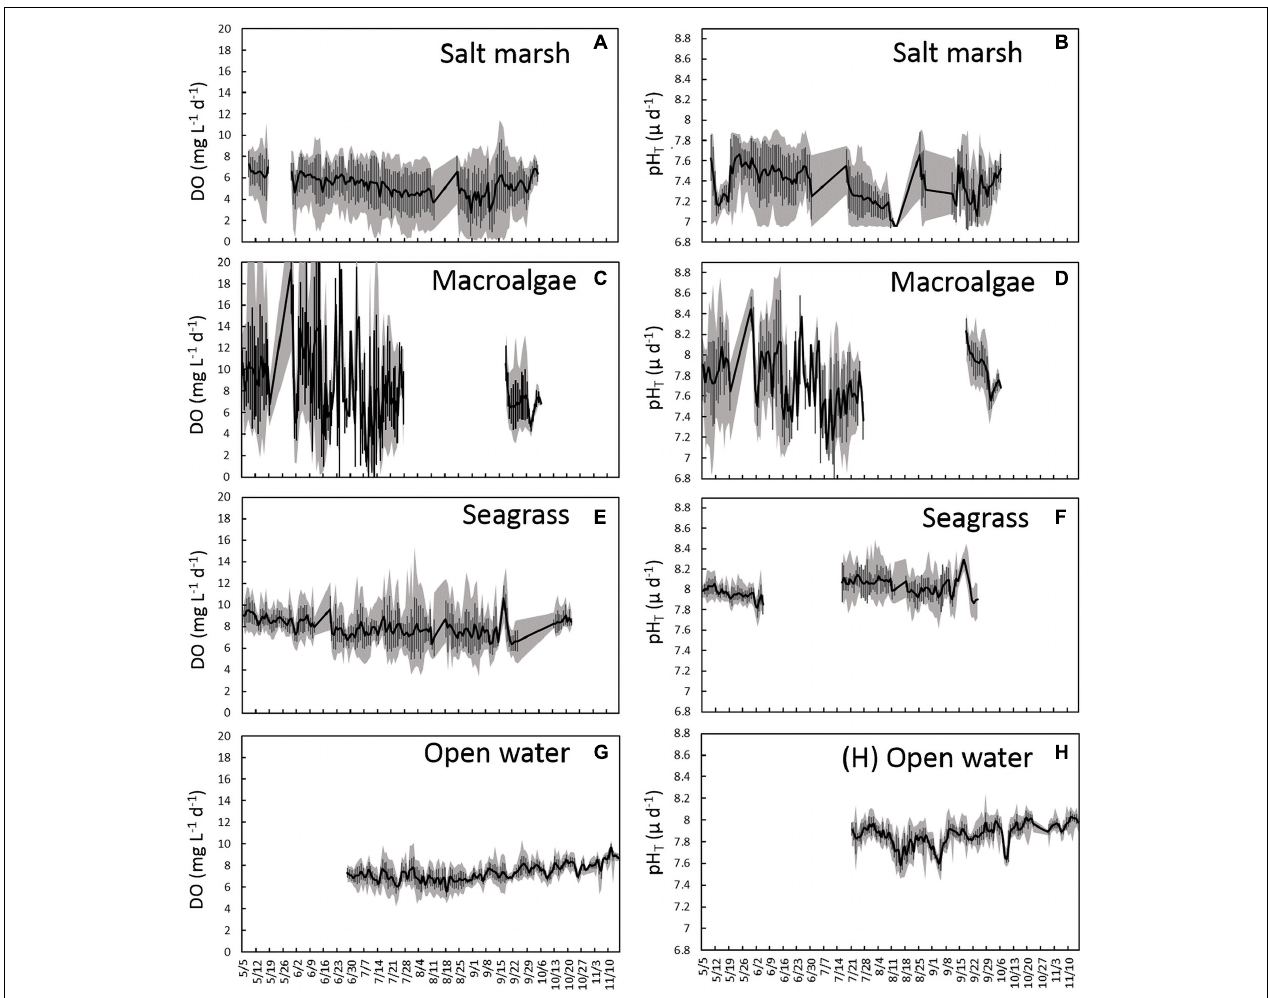
FIGURE 3 | Time series plots representing mean (A) DO mg L − 1 d − 1 ± SD and (B) pH T d − 1 ± SD (black lines and error bars) in a salt marsh (SM-3), (C) DO mg L − 1 d − 1 ± SD and (D) pH T d − 1 ± SD (black lines and error bars) in a macroalgae-dominated creek (MA-1), (E) DO mg L − 1 d − 1 ± SD and (F) pH T d − 1 ± SD (black lines and error bars) in a seagrass bed (SG-1), and (G) DO mg L − 1 d − 1 ± SD and (H) pH T d − 1 ± SD (black lines and error bars) in an open water estuary (OW-1). The gray shaded area represents the maximum daily range each day.